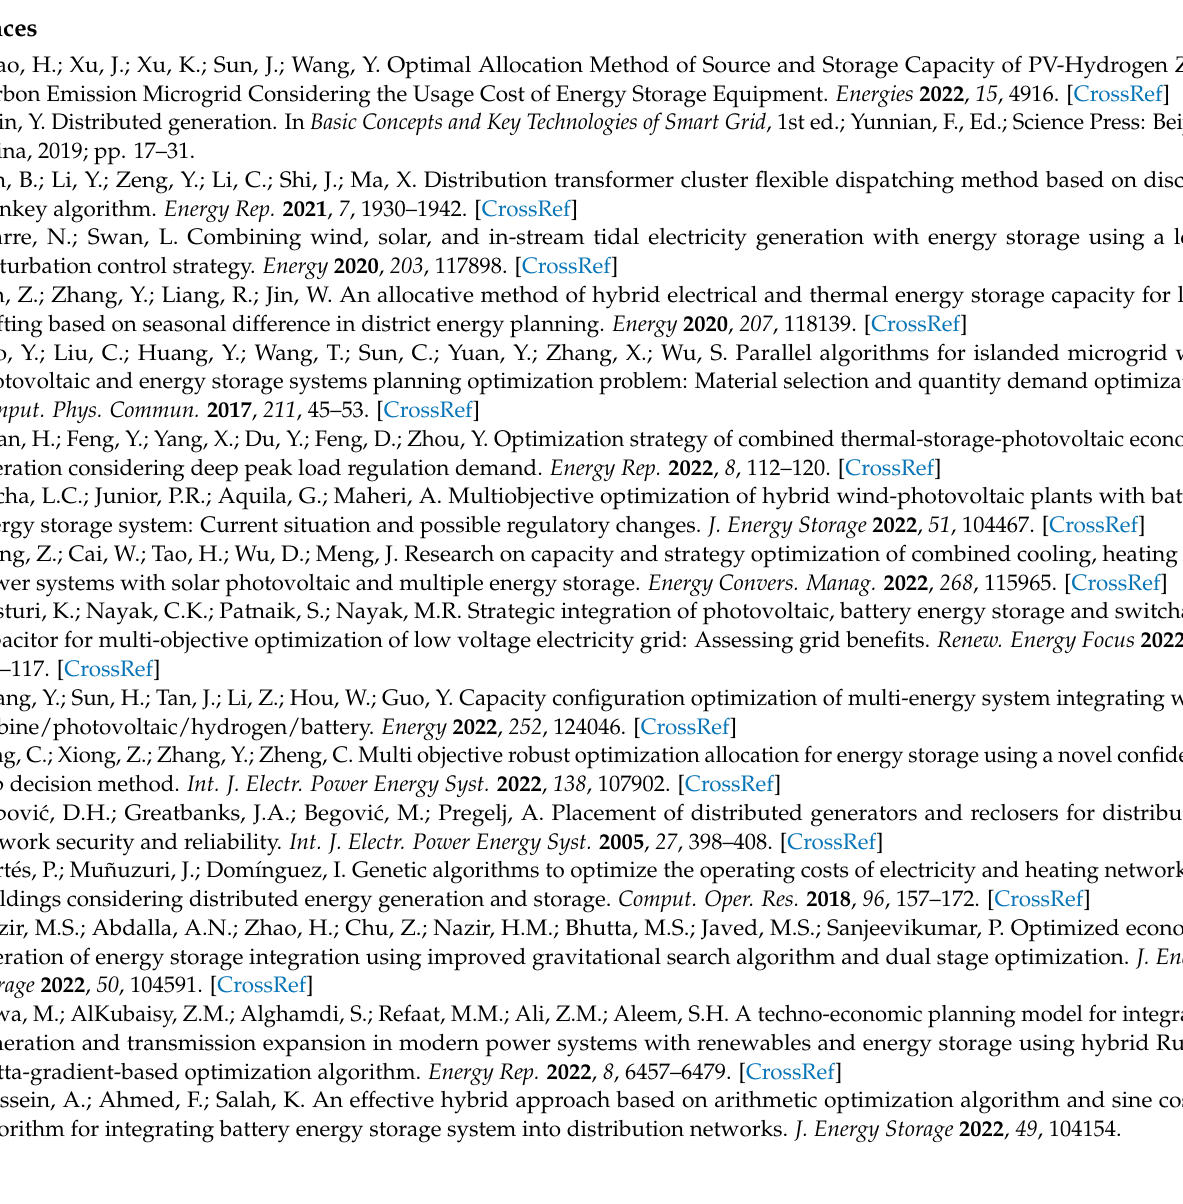
Figure A1. The time series curve of load demand and PV output on the 15th day of each month: ( a ) daily time series load demand curve; ( b ) daily time series PV output